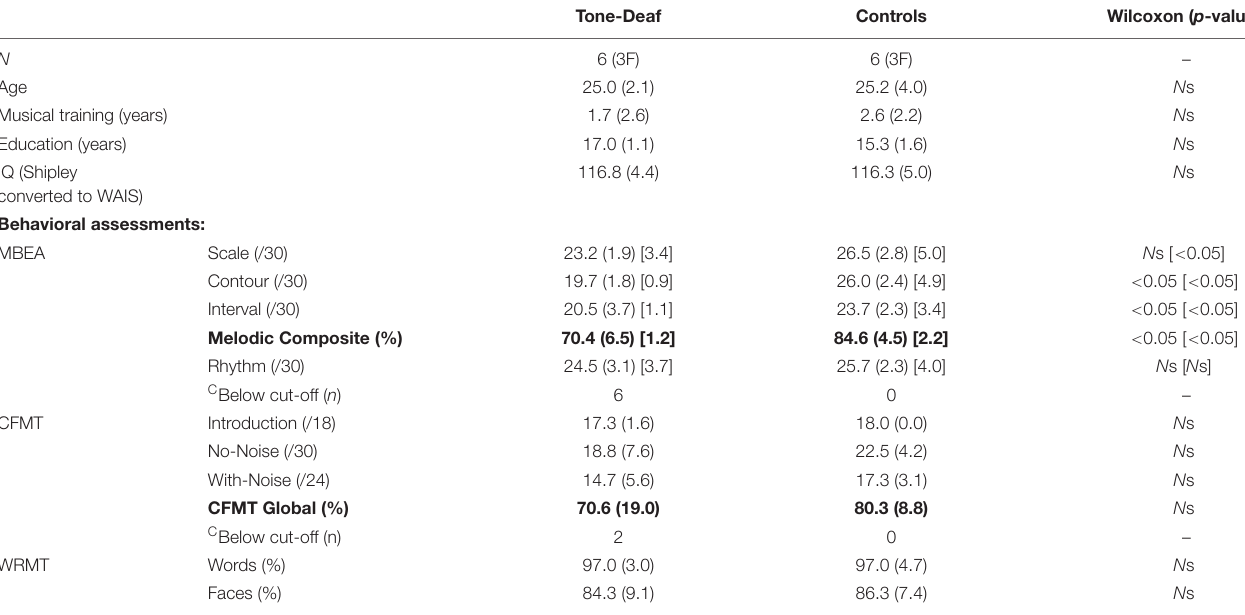
TABLE 1 | Group average demographic characteristics and average scores on the different behavioral assessments: MBEA, CMFT, and WRMT sub-tests